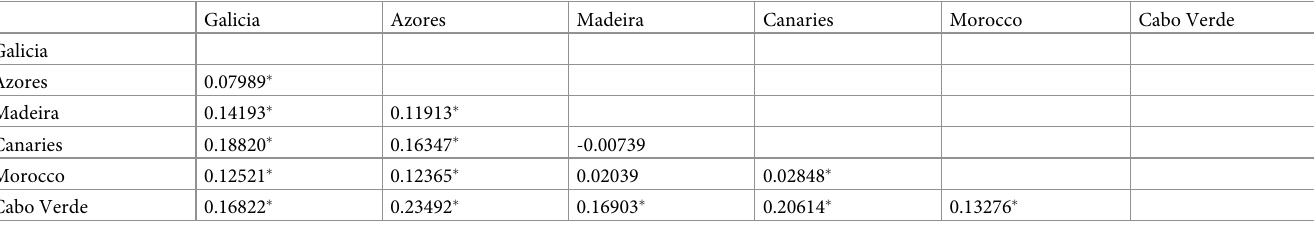
Table 2. Population pairwise F ST values estimated from the mitochondrial control region. Galicia Azores Madeira Canaries